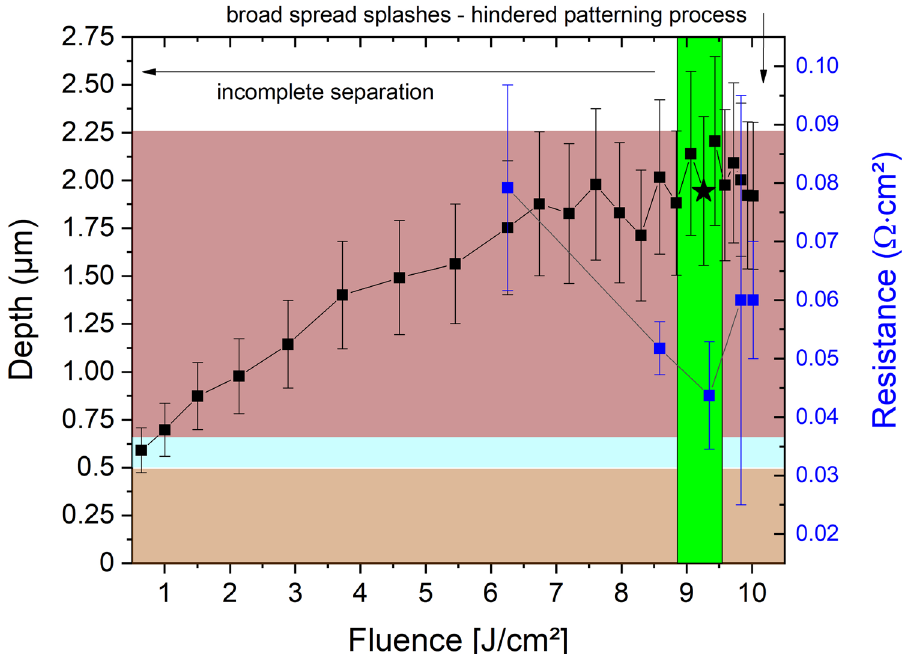
Fig. 7. P2 scribe line depth (right y -axis, black squares) and electrical resistance across the scribe line (left y -axis, blue squares) as a function of the applied laser fl uence. The range of suitable fl uences is marked by the light green area, the selected fl uence with an asterisk. The brownish area illustrates the perovskite layer, the cyan area refers to the window layer stack, and the dark red area refers to the CIGSe absorber